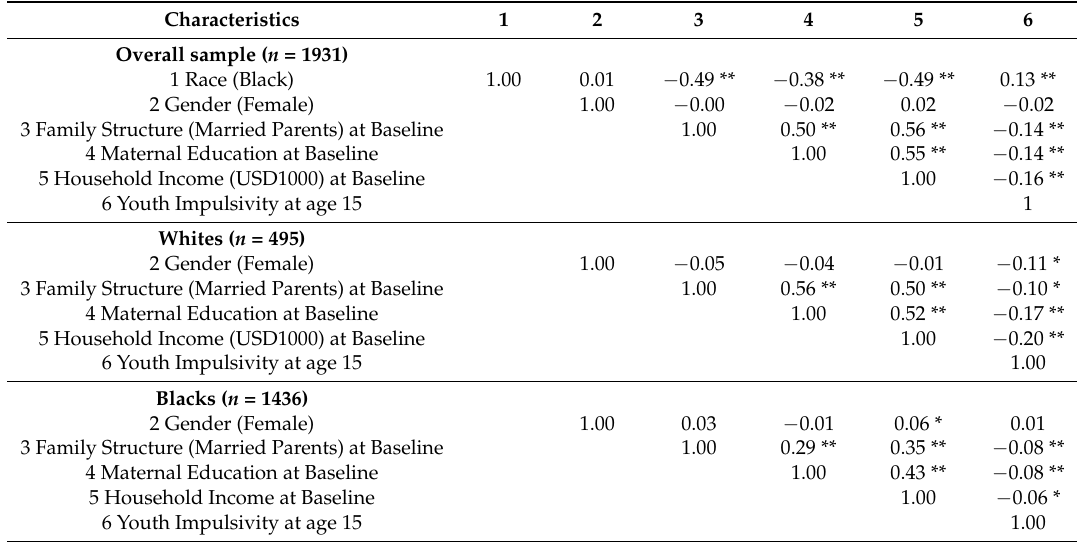
Table 2. Bivariate correlations in the overall sample and across races ( n = 1931).